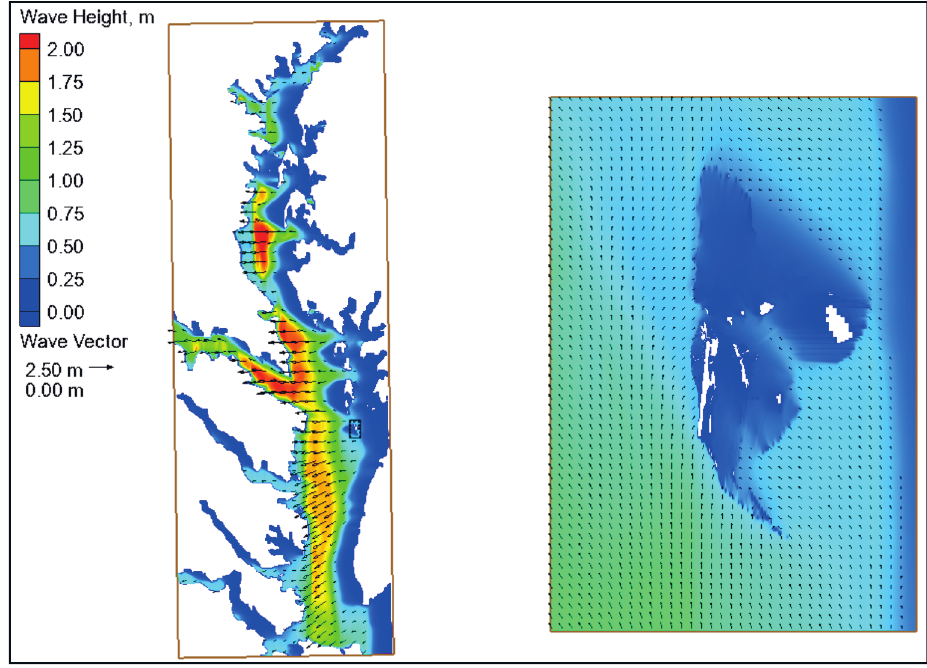
Figure 29. Calculated maximum wave height fields during Hurricane